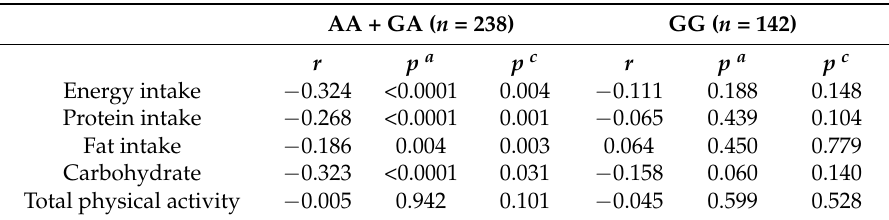
Table 3. Correlation between leptin and lifestyle factors within UCP2